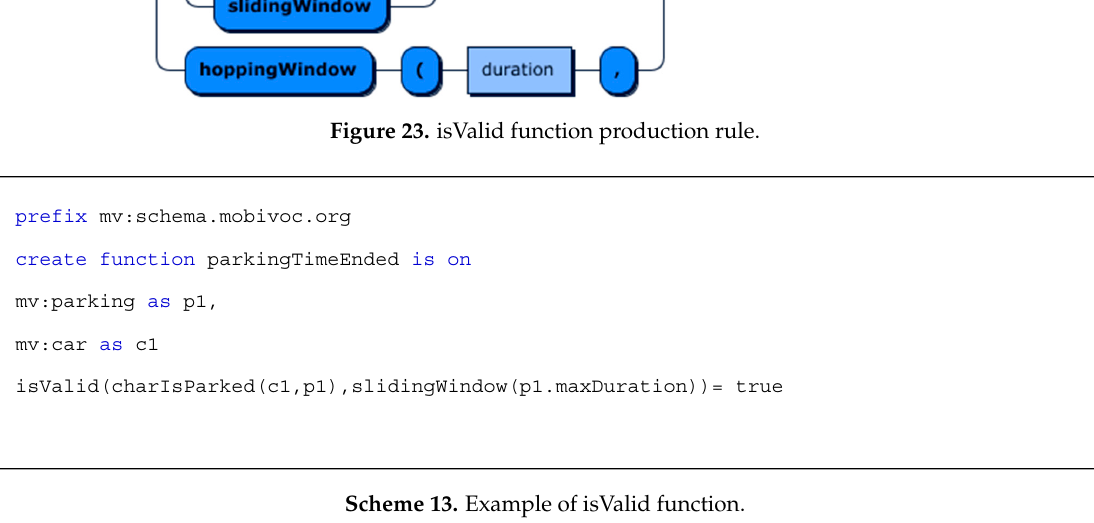
Figure 23. isValid function production rule.